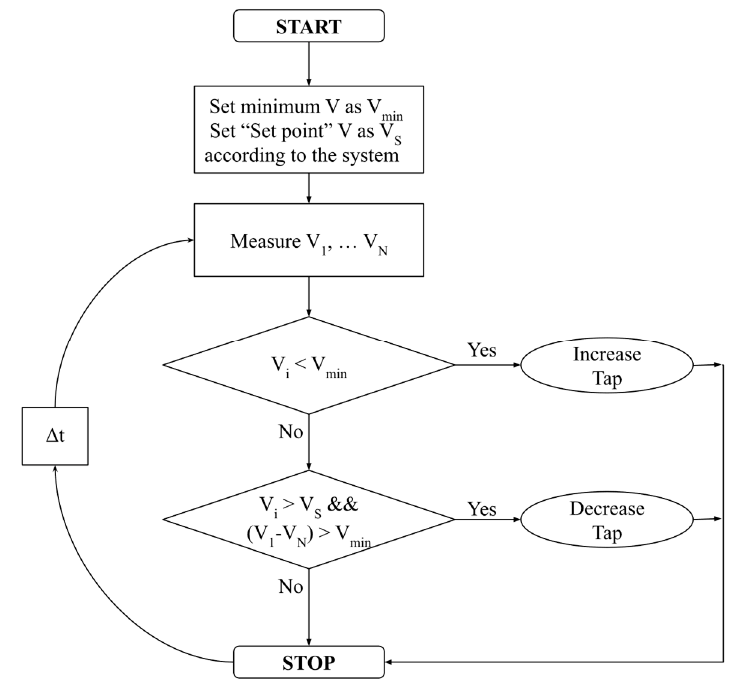
Figure 1. DSM techniques.